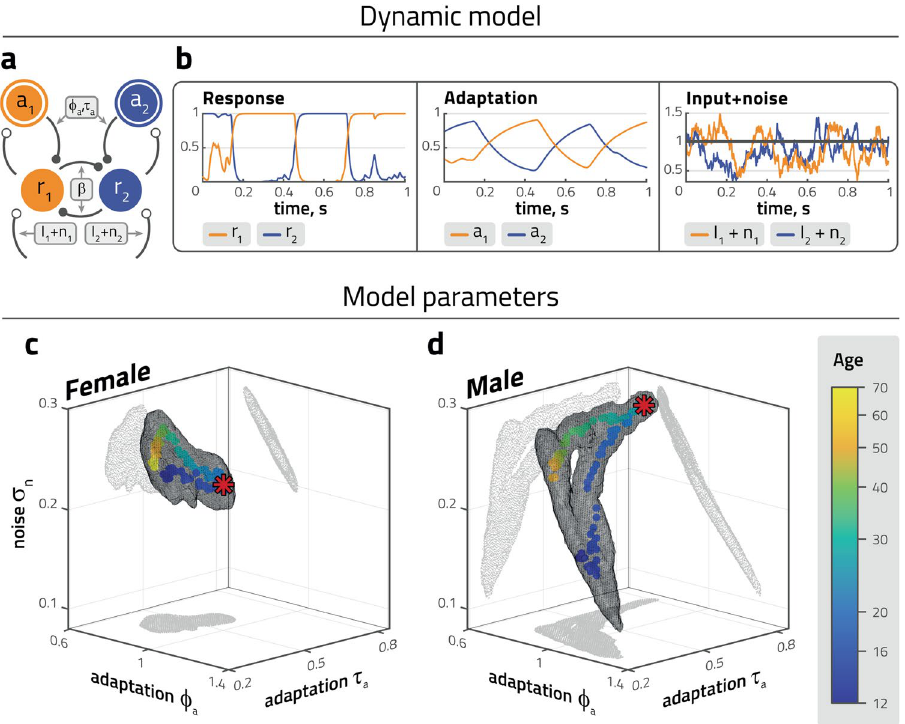
Figure 3. Development and maturation of fitted model parameters. ( a ) Dynamic model of binocular rivalry, with competition, adaptation, and noise. Two representations ( r 1 , r 2 ) are driven by associated visual inputs ( I 1 , I 2 ) and independent noise ( n 1 , n 2 ). Each representation is inhibited by the other, as well as by the associated adaptive state ( a 1 , a 2 ). Free model parameters are competition strength ( β ), adaptation strength ( φ a ), adaptation time-scale ( τ a ), and noise amplitude ( σ n ). Input strength is fixed at I 1 of model dynamics with abrupt dominance reversals of activities r 1 and r 2 , gradual build-up and recovery of adaptive states a 1 and a 2 (middle), and noise n 1 and n 2 added to visual input I 0.2 ). Reversals may be triggered by differential adaptive state a 1 σ n = ( c , d ) Parameter triplets φ a - τ a - σ n fitted to reproduce (within a ±5%) experimentally observed mean distribution parameters. Competition strength was fixed at β standard deviation, grey mesh). Red stars represent peak age of maturation index (Fig.